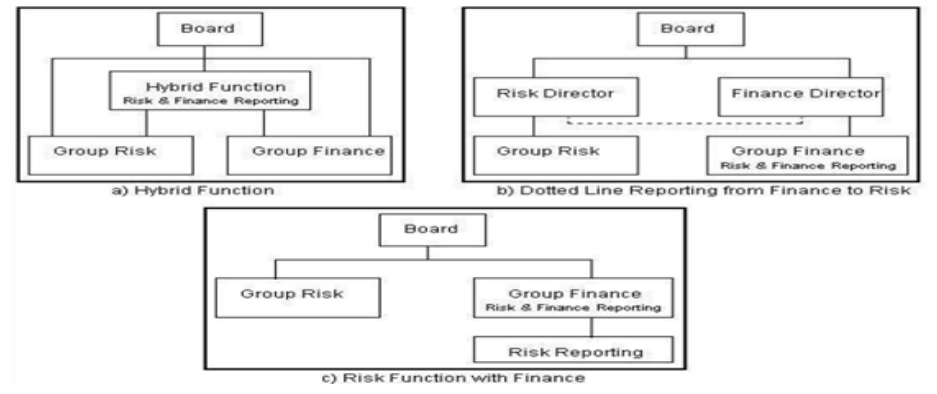
Fig. 1. Organisational structure of risk management Source: KPMG “Basel Briefing